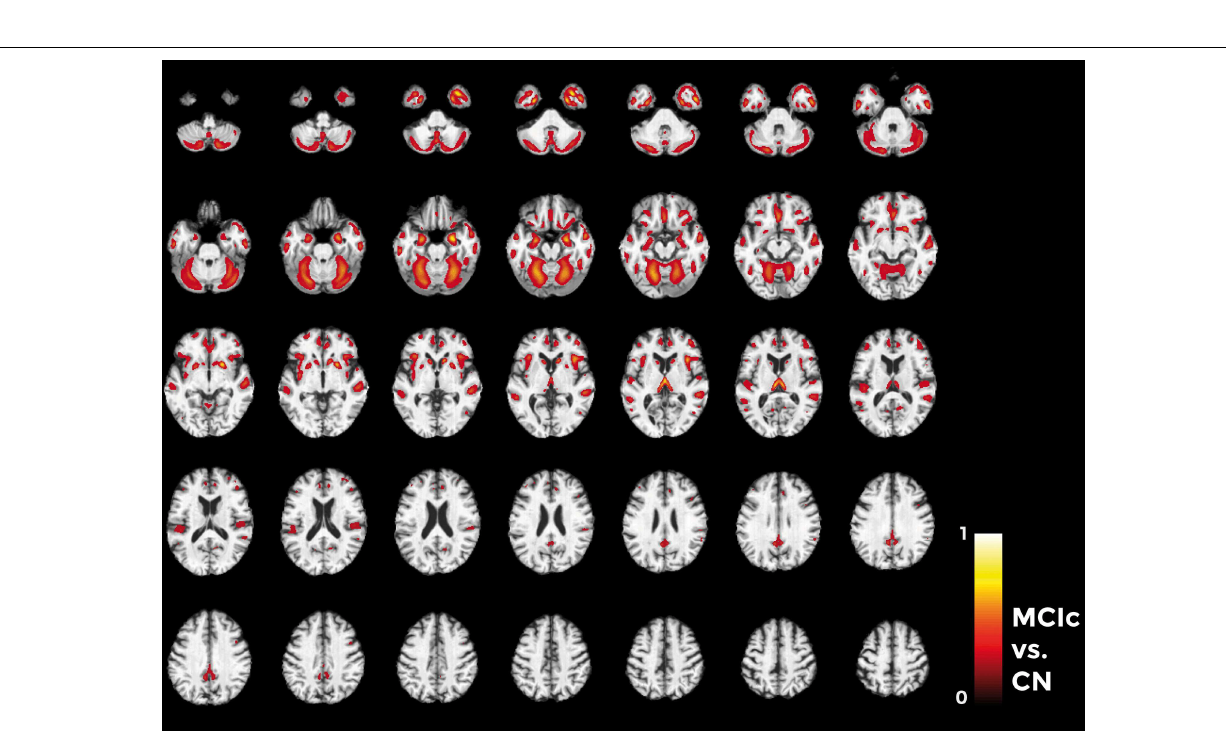
Frontiers in Neuroscience |